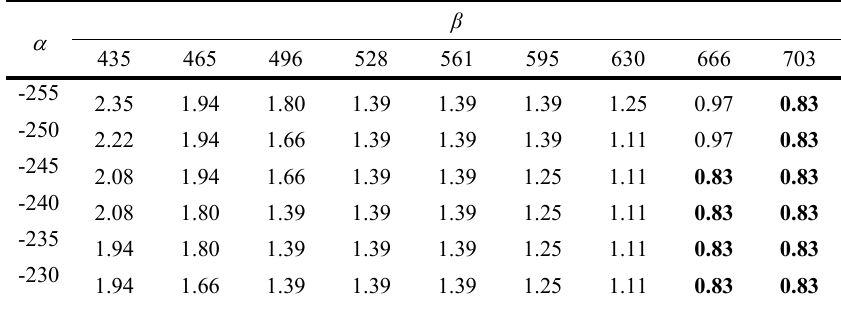
Table 3(b). Variation in percentage error rate for some values of α and β on subset 5 of extended Yale B